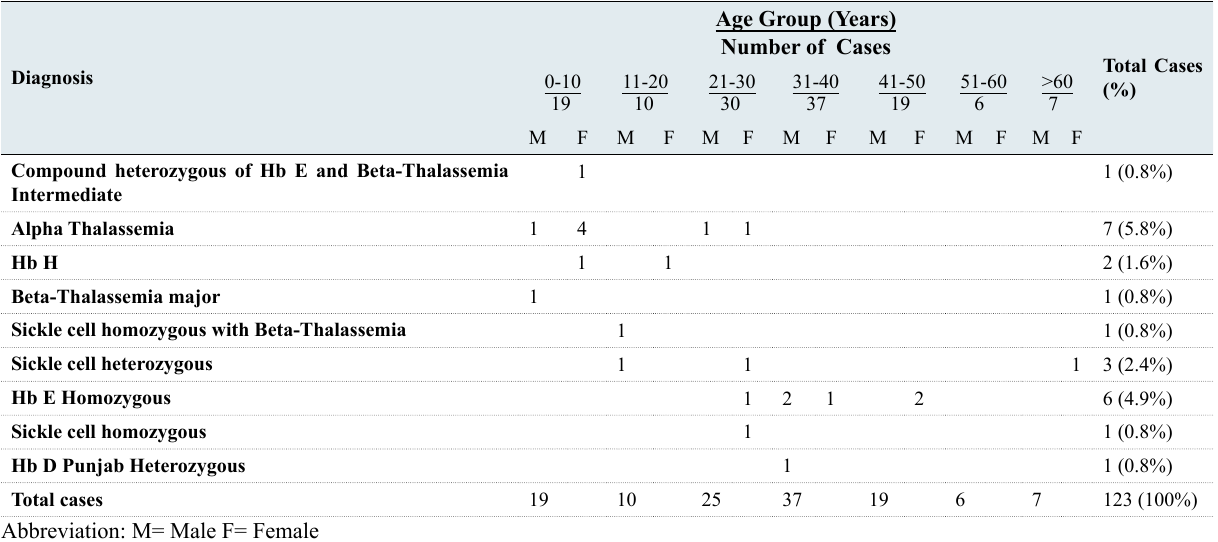
Abbreviation: M= Male F= Female